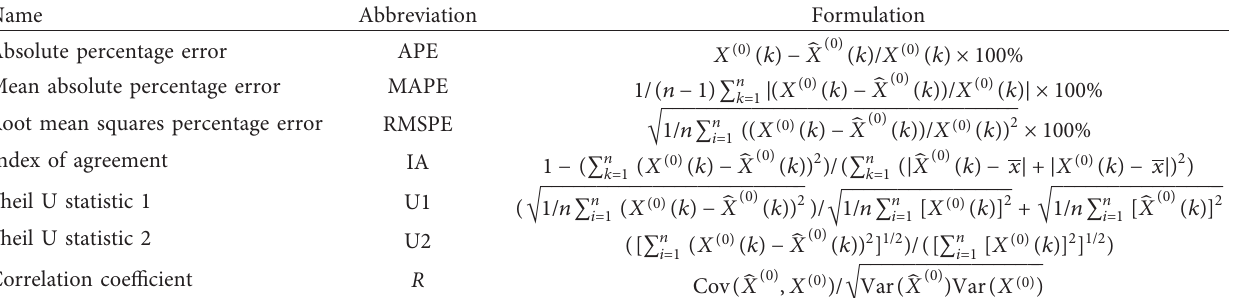
Table 3: Metrics for evaluating effectiveness of the models [34].